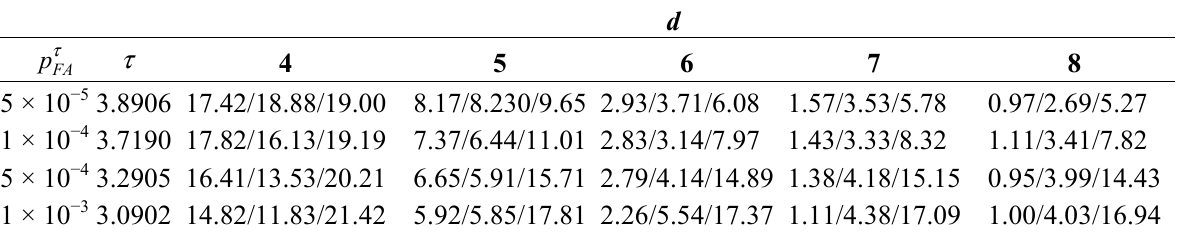
Table 2. Average OSPA (pixel) for different